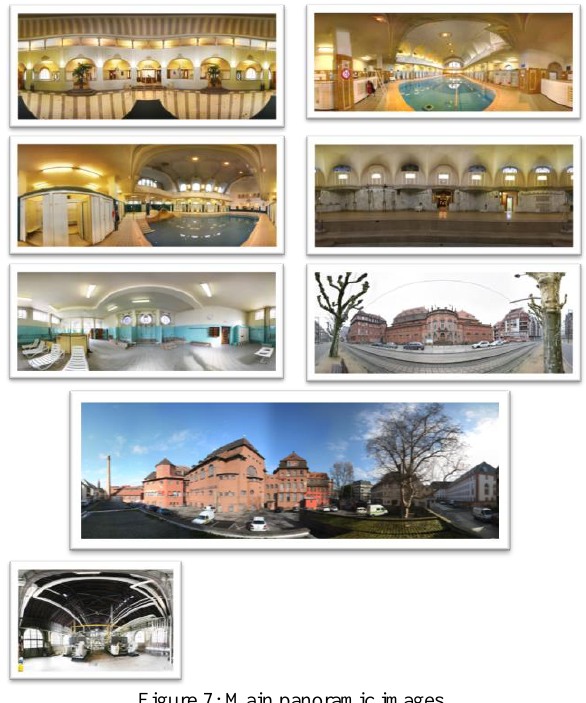
Figure 7: Main panoramic